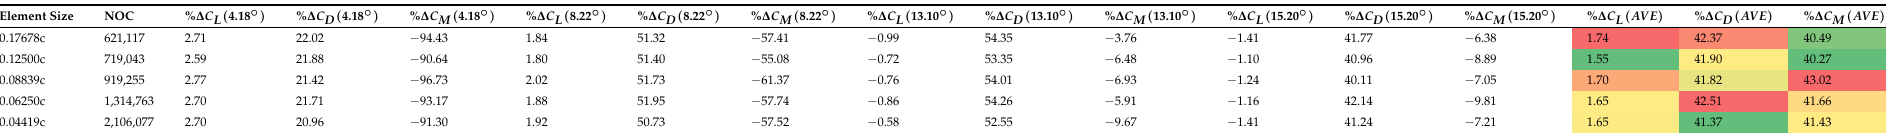
Table 21. Comparison of the results of Hybrid-mesh based on various element sizes with that of experimental benchmark data adopted from [25] in relative differences.